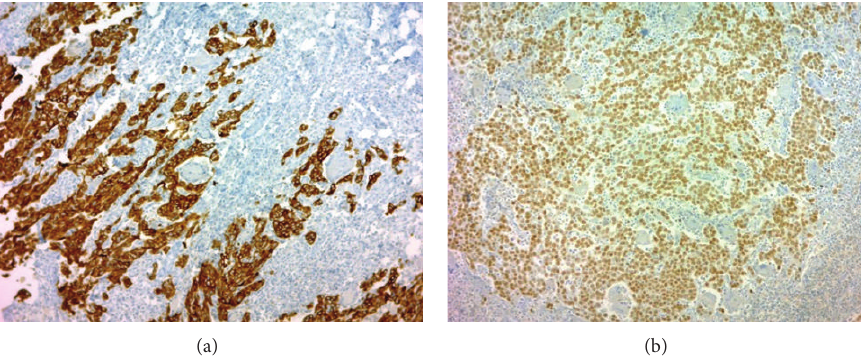
Figure 3: (a) Reactivity to cytokeratin in the squamous component, lack of reactivity in osteoclastic giant cells. Immunohistochemical stain with anti-CK antibody, × 50. (b) Reactivity to P63 in the squamous component, lack of reactivity in osteoclastic giant cells. Immunohistochemical stain with anti-P63 antibody, × 50.